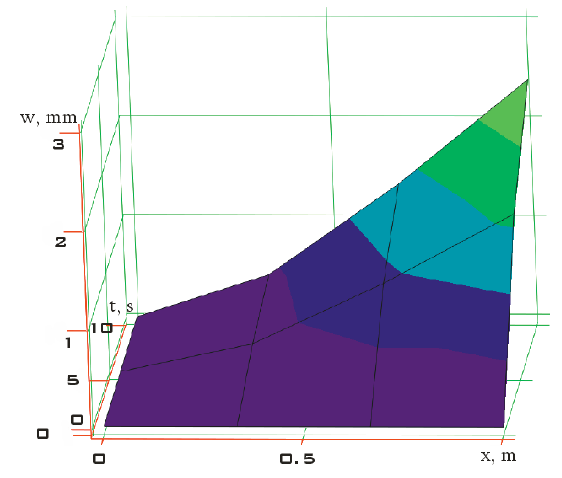
Figure 4. The function w ( x , t ) for A = 10 —4 m —3